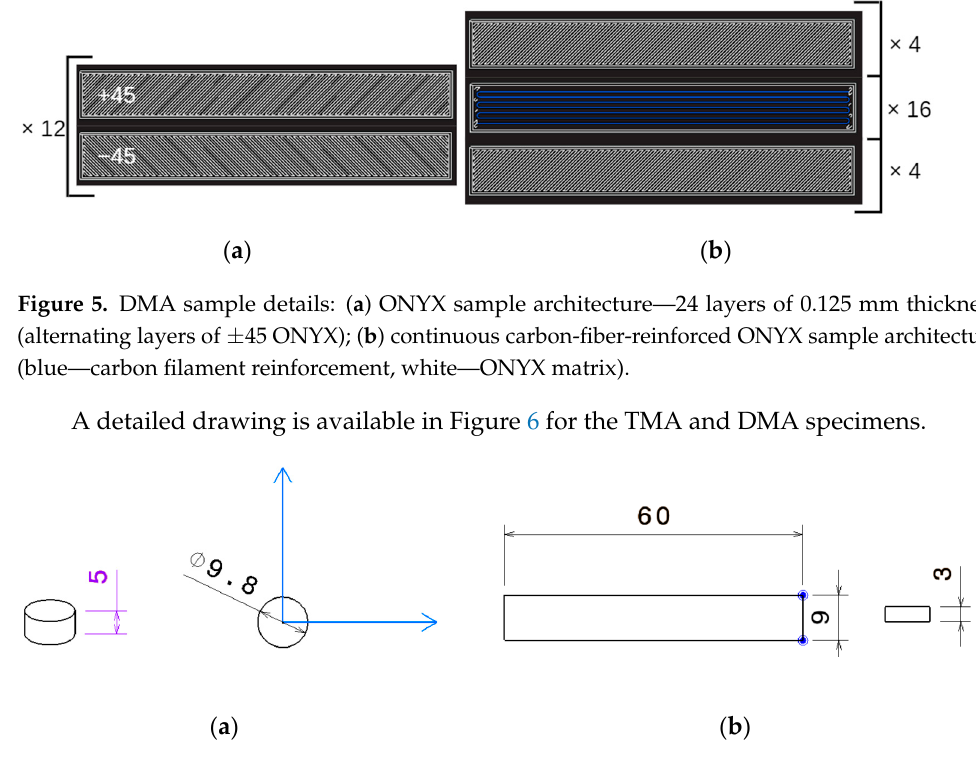
Figure 4. TMA sample details: ( a ) sample geometry; ( b ) ONYX sample architecture—40 layers of 0.125 mm thickness (alternating layers of ± 45 ONYX); ( c ) continuous carbon-fiber-reinforced ONYX sample architecture (blue—carbon filament reinforcement, white—ONYX matrix).